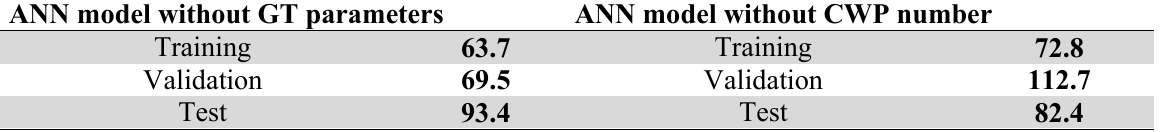
Sensitivity analysis of ST model